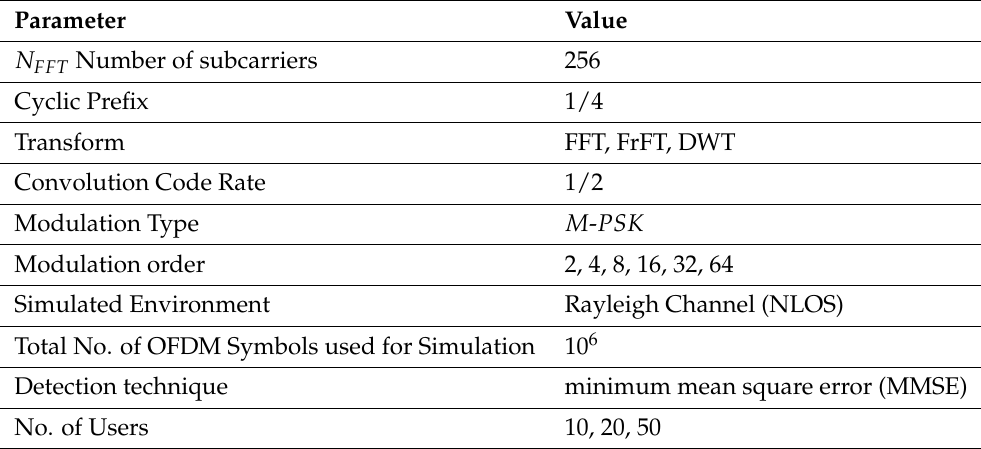
Table 2. Simulation